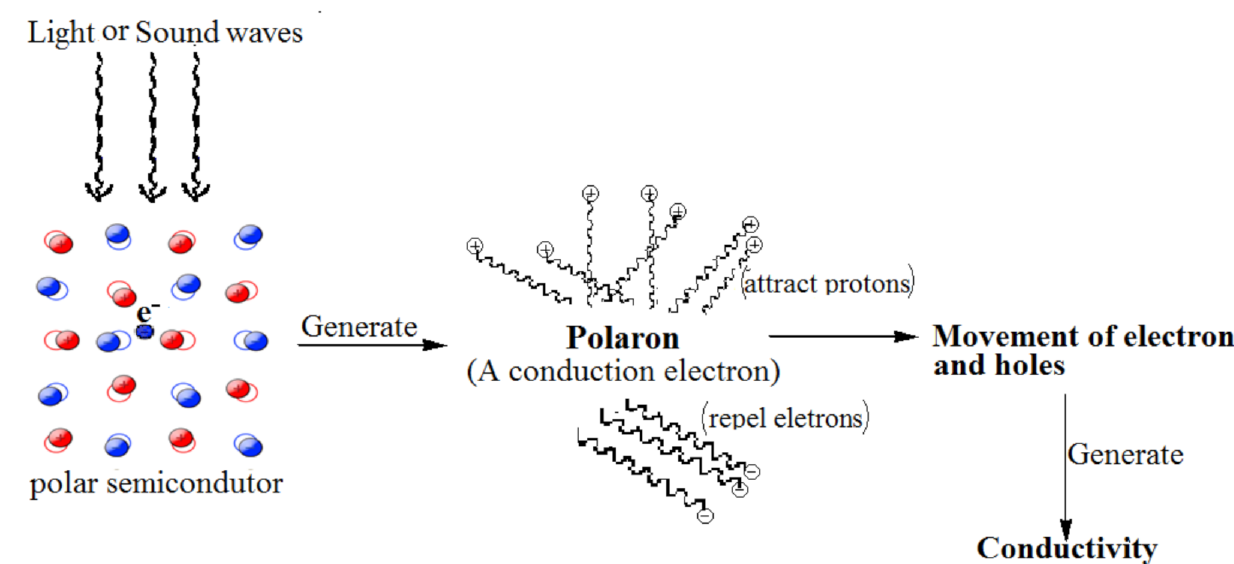
Figure 5. Conduction mechanism through polaron